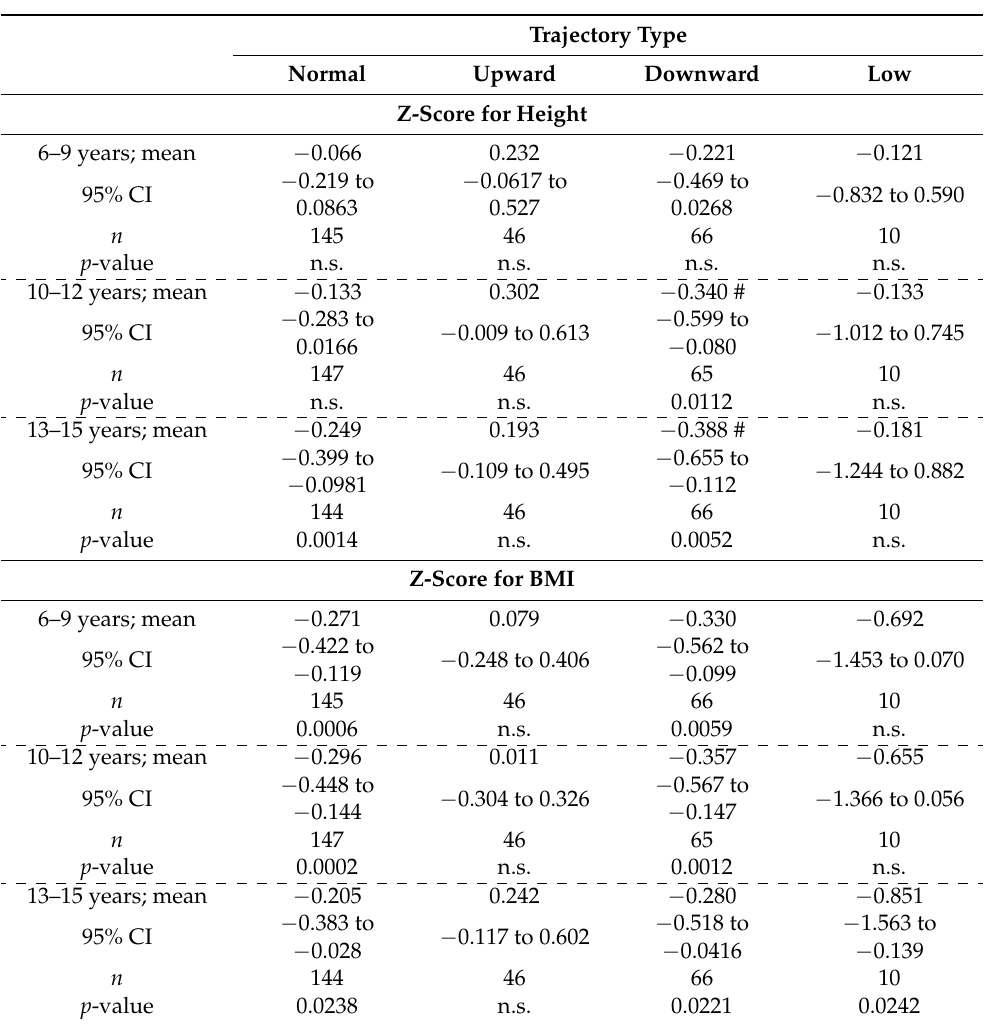
Table 2. Anthropometric data of the